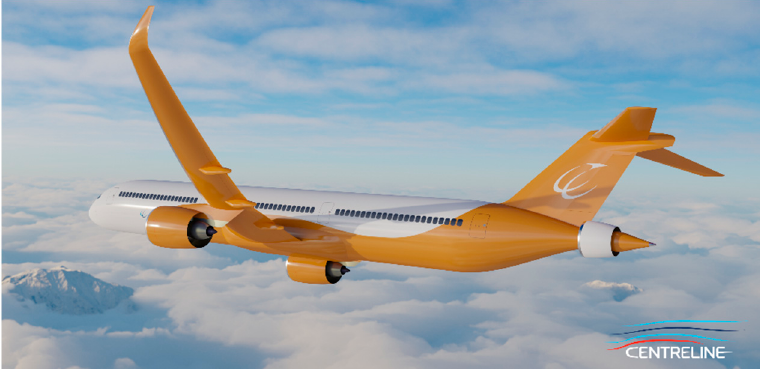
Figure 1. Artist view of the CENTRELINE turbo-electric propulsive fuselage aircraft design.